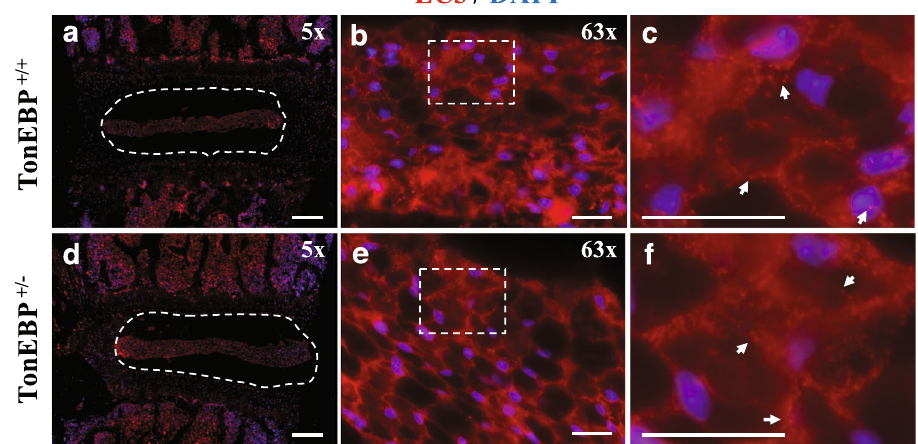
Figure 2. TonEBP haploinsufficient mice do not show altered autophagy in NP. LC3 immunofluorescence staining of intervertebral discs from 4-month-old TonEBP + / + ( a – c ) and haploinsufficient TonEBP + / − ( d – f ) mice demonstrated similar pattern and distribution of LC3 positive autophagosomes. ( a , d ) White dotted line demarks the NP tissue compartment. ( c , f ) Magnified images of dotted inserts from B and E respectively. White arrows indicate LC3-positive autophagosomes. Scale bar: 200 μ m for ( a ) and ( d ); 20 μ m for ( b ), ( c ), ( e ), and ( f